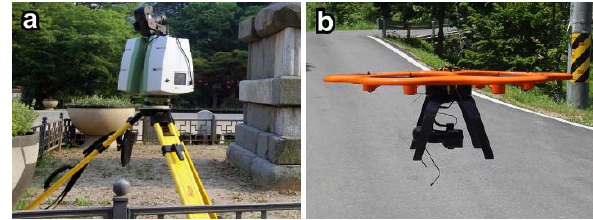
Figure 2. Equipment used for scanning and photogrammetry: (a) Terrestrial laser scanner with specialized external camera; (b) Hexacopter UAV